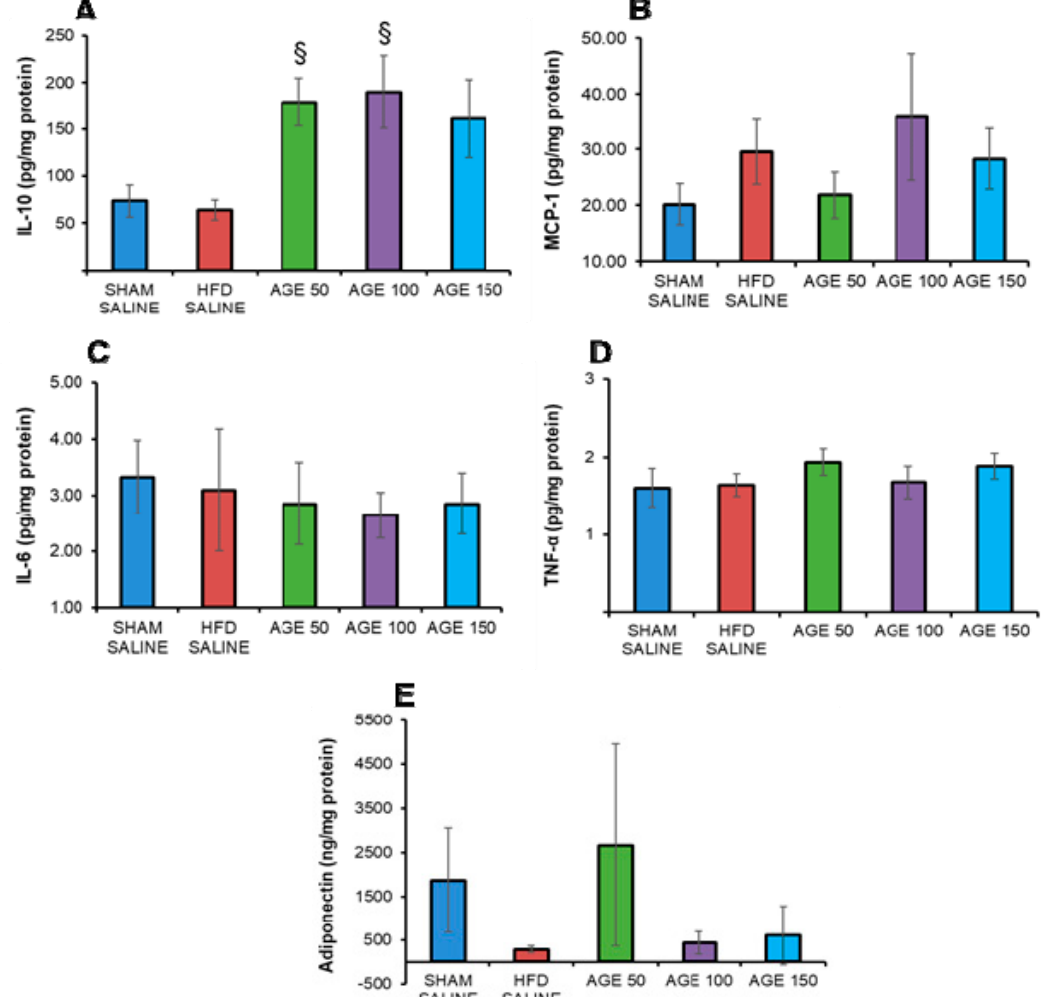
Figure 5. Effects of AGE on anti- and pro-inflammatory cytokines, chemokines and adiponectin. ( A ) Interleukin-10 (pg / mg protein). ( B ) Interleukin-6 (pg / mg protein). ( C ) Monocyte-1 chemotactic protein (pg / mg protein). ( D ) Tumor necrosis factor alpha (pg / mg protein). ( E ) Adiponectin (ng / mg protein) of control animals (SHAM SALINE: standard diet + saline solution. HFD SALINE: